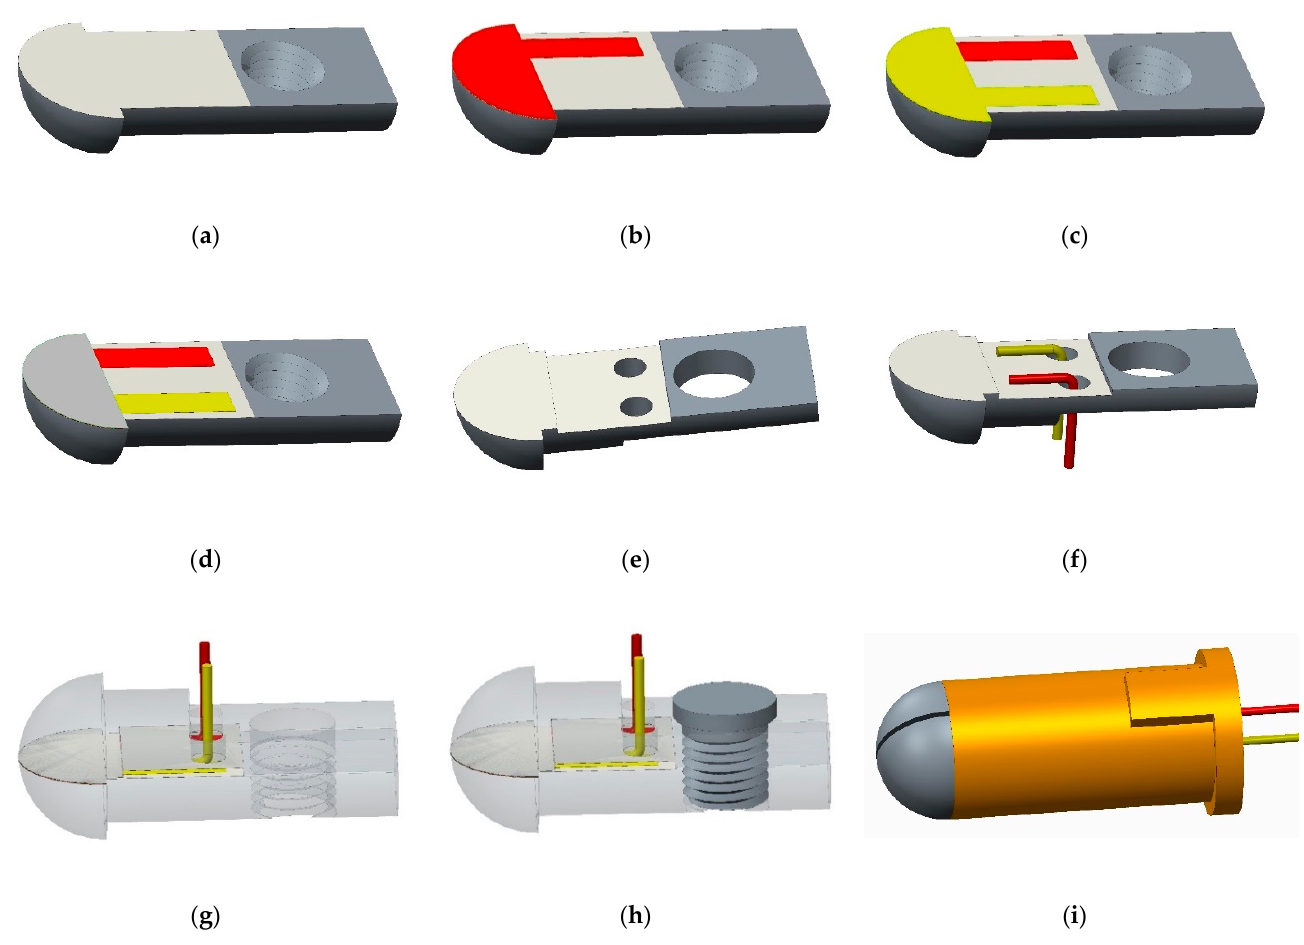
Figure 4. The preparation and assembly process of adaptive film thermocouple temperature sensor: ( a ) deposition of Al 2 O 3 insulating film; ( b ) deposition of NiCr functional films; ( c ) deposition of NiSi functional films; ( d ) deposition of SiO 2 protective film; ( e ) deposition of Al 2 O 3 insulating film with groove structure; ( f ) compensation conductor passes through the through-hole of the groove structure; ( g ) base and groove structure snap together; ( h ) flat head screws secure the base and recessed structure; ( i ) hot pressing assembly sheathed sleeve.